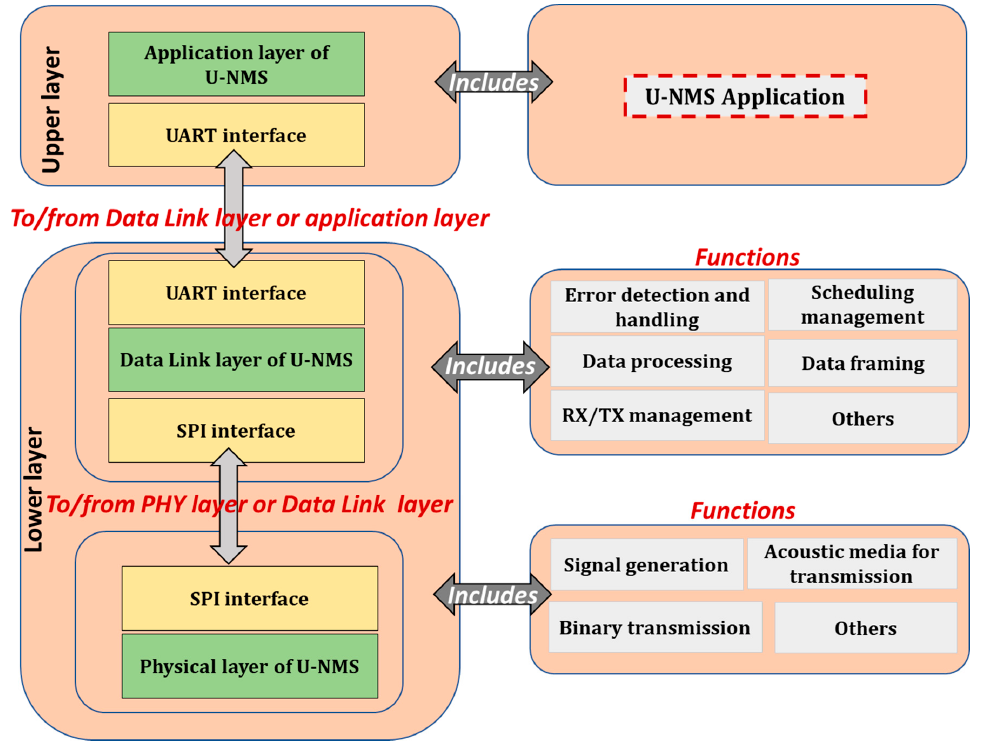
Figure 17. Protocol stack of U-NMS.